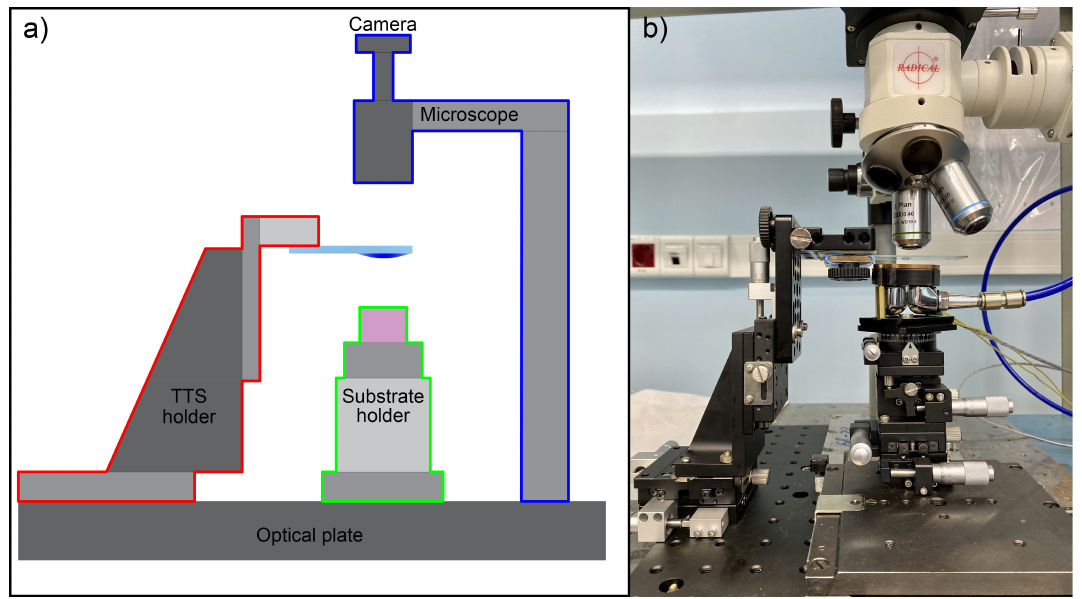
Figure 2. ( a ) Schematics of the transfer machine; ( b ) photo of our